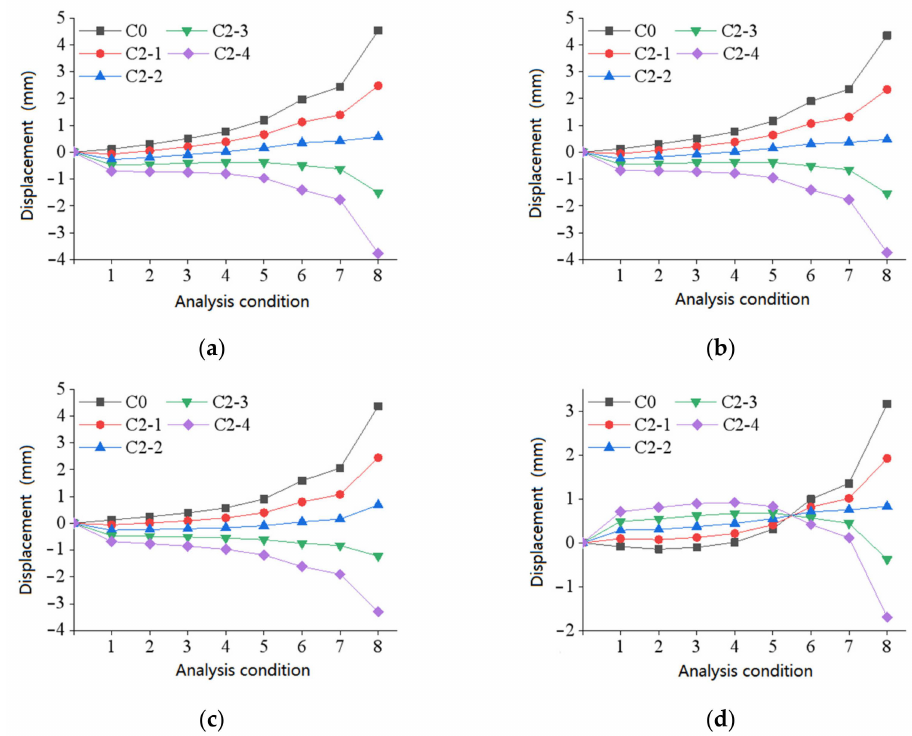
Figure 8. Model C2/C0 displacement analysis results (mm): ( a ) W2 displacement change; ( b ) W3 displacement change; ( c ) W4 displacement change; ( d ) W5 displacement